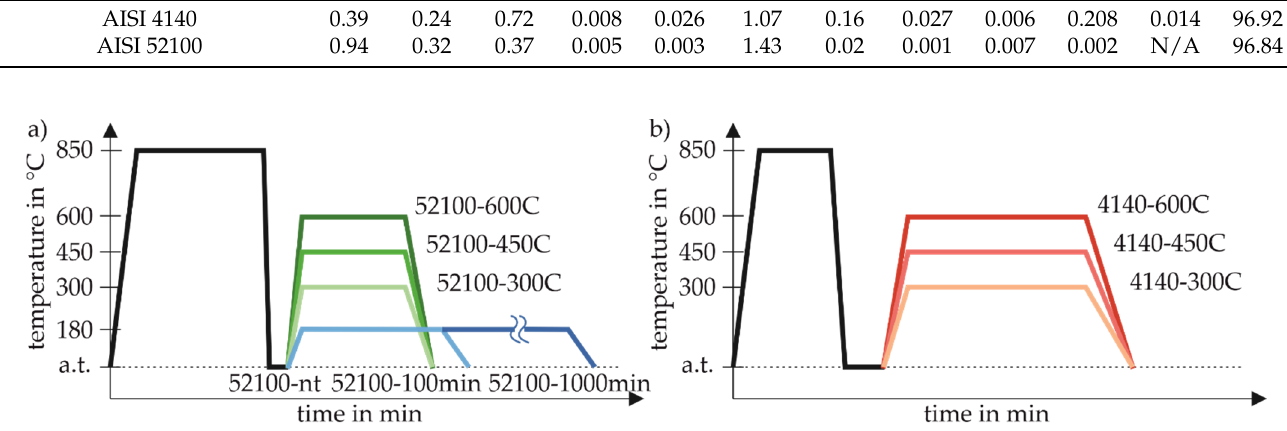
Figure 1. Schematic illustration of the different heat treatments applied to the specimens. ( a ) The heat treatments temperature-time curves applied on the AISI 52100 batch, ( b ) applied on the AISI 4140 batch.